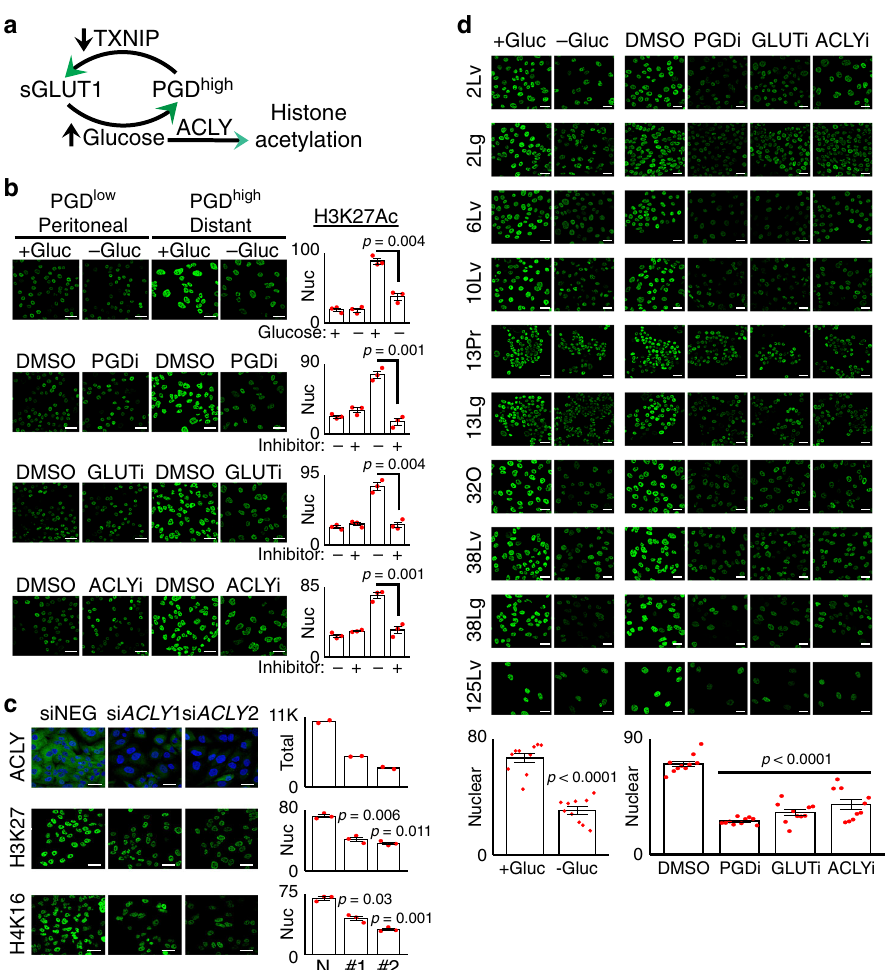
Fig. 5 A PGD-GLUT1-ACLY pathway hyperacetylates metastatic chromatin. a Illustration of how PGD-driven retention of surface GLUT1 can provide excess glucose for ACLY-dependent histone hyperacetylation. b Glucose deprivation ( − Gluc, top row), PGD inhibition (PGDi, second row), GLUT1 inhibition (GLUTi, third row), and ACLY inhibition (ACLYi, bottom row) all reduced global H3K27Ac in the nuclei of PGD high 38Lg cells (right panels) down to levels comparable with PGD low 38Per controls from the same patient (left panels) by confocal IF. c Treatment of PGD high 38Lg cells with siRNAs against ACLY (#1, #2) knocked down ACLY expression (top panels, n = 2 biological replicates) and reduced histone acetylation (H3K27Ac: middle panels;, H4K16Ac: bottom panels; n = 3 biological replicates) relative to nontargeting siRNA controls (siNEG). d Glucose deprivation, PGDi, GLUT1i, and ACLYi recurrently lowered H3K27Ac across the full complement of PGD high subclones (left-hand labels). Quanti fi ed nuclear H3K27Ac values for all the indicated experiments pooled together are plotted at the bottom. For all IF experiments (unless otherwise indicated): green, antibody signal, n = 3 biological replicates, error bars: s.e.m., indicated p values calculated by two-tailed t tests, scale bars: 20 µ